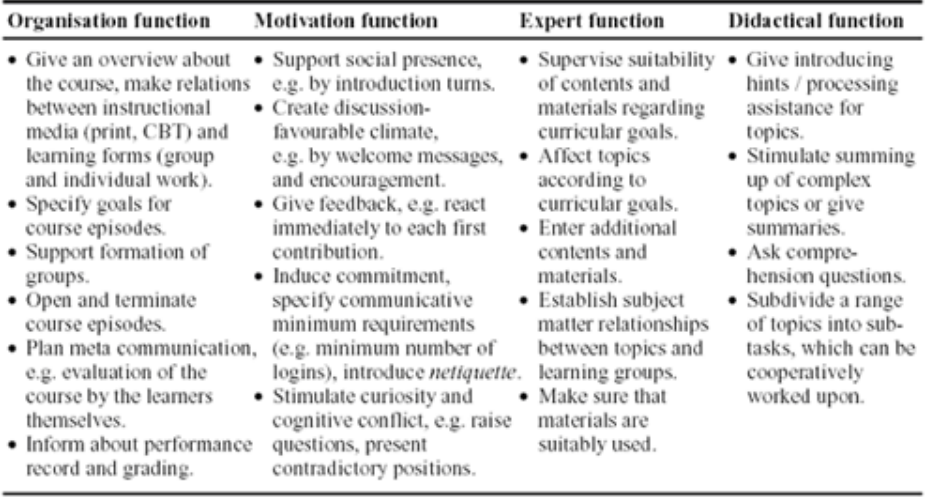
Figure 1. CMC moderator functions (after Hron and Friedrich, 2003)